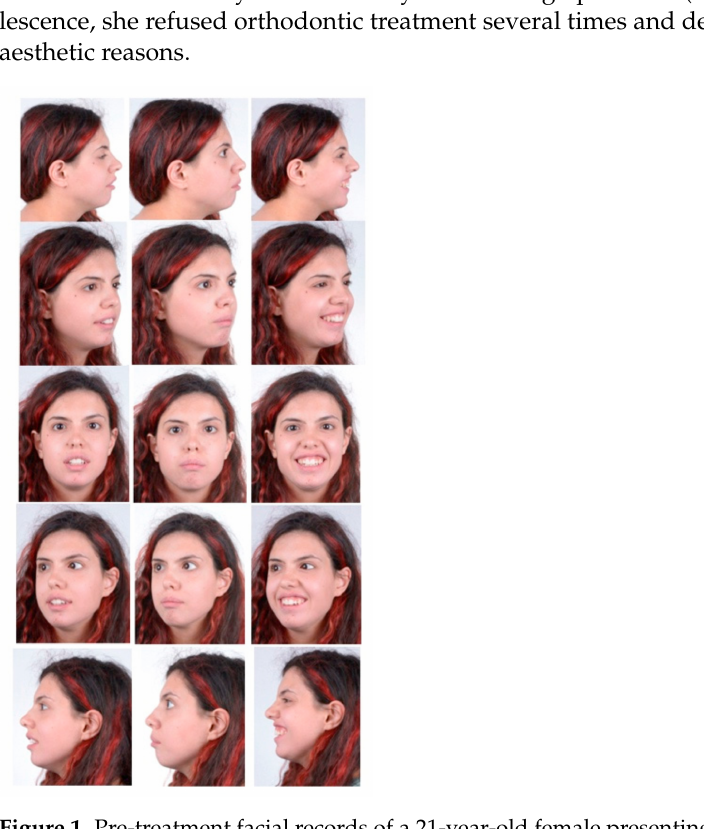
Figure 1. Pre-treatment facial records of a 21-year-old female presenting asymmetric gummy smile, mandibular deficiency and lips